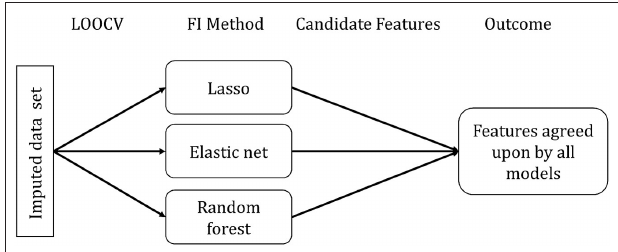
FIGURE 3 | Feature importance (FI) analysis pipeline. FI Method indicates the specific method for each model to extract the relevant features.